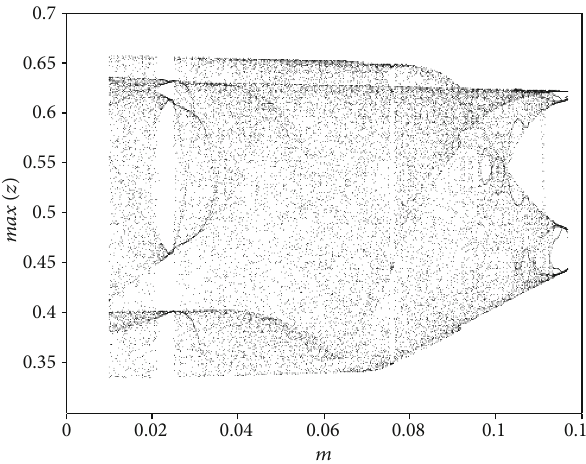
Figure 3: Bifurcation diagram of system (3) using data (87) with varying m , the trajectory of z versus m in the range ð 0,0 : 15 Þ